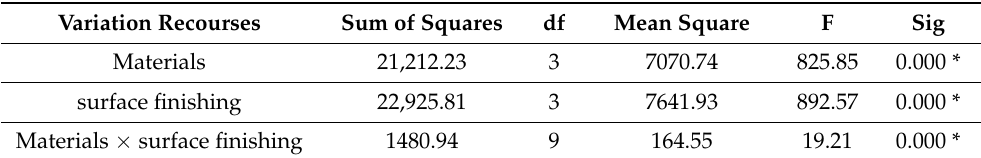
Table 6. MANOVA of biaxial flexural strength (BFS).